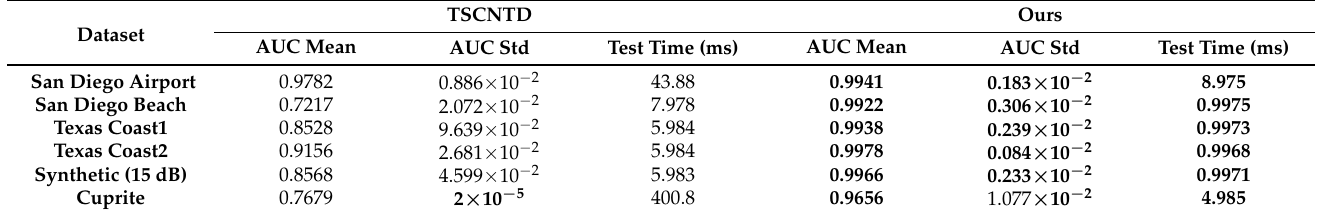
Table 5. Detection performance and efficiency comparison of the two-stream convolutional network- based target detector (TSCNTD) and our method. The best results are reported in